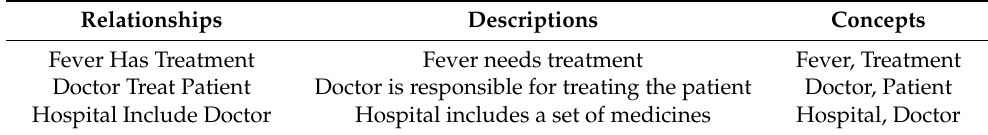
Table 4. Examples of solution relationships.